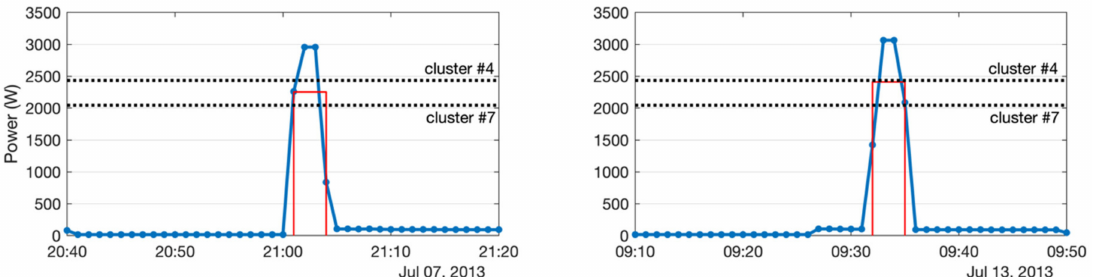
Figure 15. Explanation of the advantage of using fuzzy clustering. Left: Kettle event miss-classified with classic clustering. Right: typical Kettle event (for comparison). Blue line shows the actual power, red line is the result of the box model, and black dotted lines represent the centroids of cluster #4 and